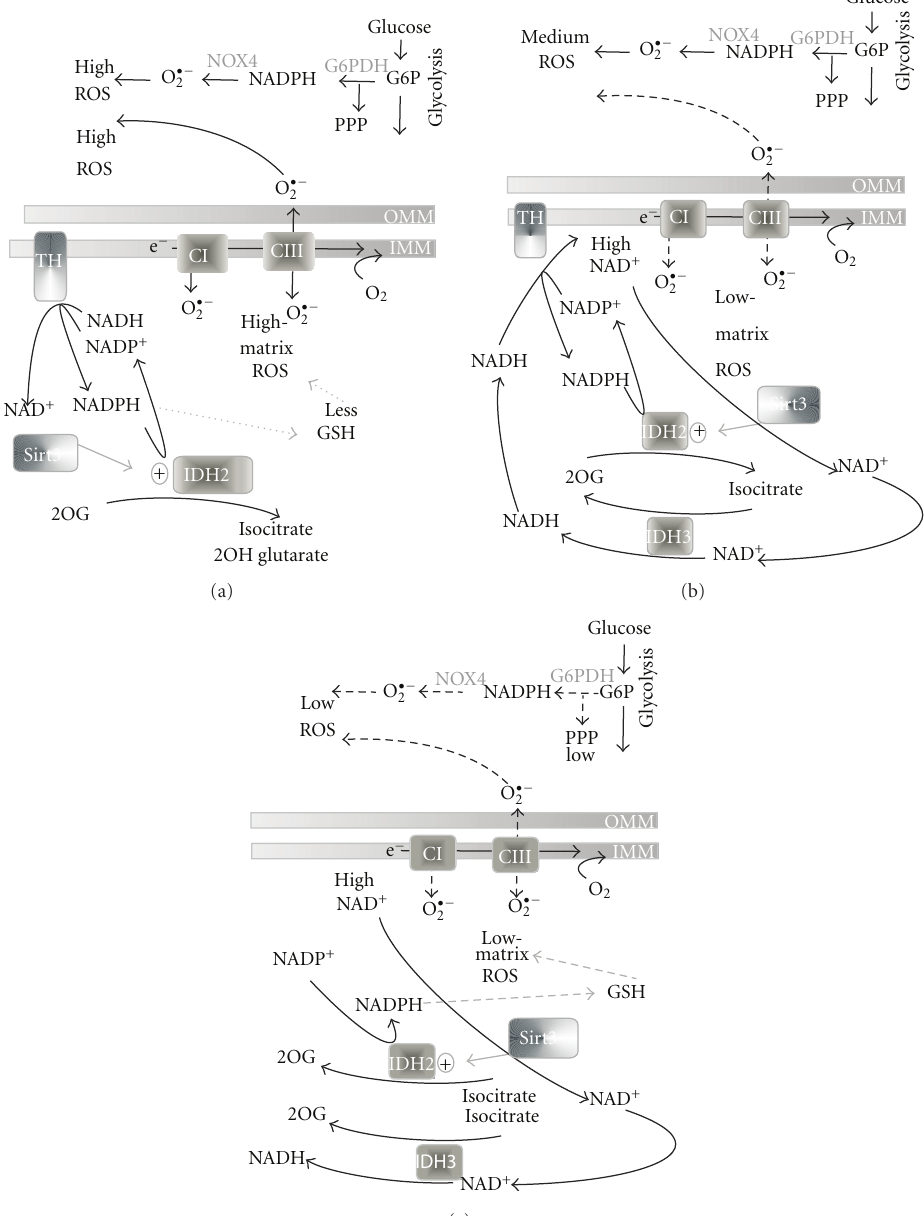
possible ongoing dissipative isocitrate/2OG cycle, which by IDH2 branch of the reaction cycle (Figure 2(b)).